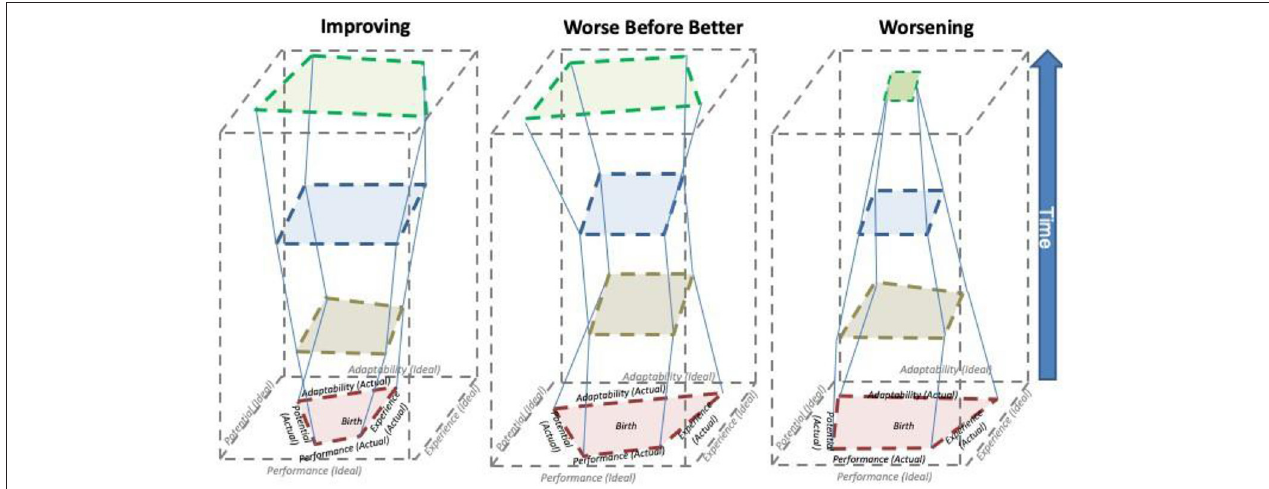
FIGURE 2 | On the left, Improving phenotype is represented by the prism in the shape of an inverted trapezoid, with its resulting volume. An example would be a premature infant with lung disease that normalizes over time with effective intervention. In the middle, the Worse before Better phenotype is represented by an hourglass shape. An example may be a neurological condition that deteriorates until an effective intervention is developed that reverses the trend. On the right, a Worsening phenotype is represented by a pyramidal prism. An example of the Worsening phenotype would be a chronic, multisystem disease diagnosed in infancy such as Tay-Sachs disease that is not amenable to new therapeutic